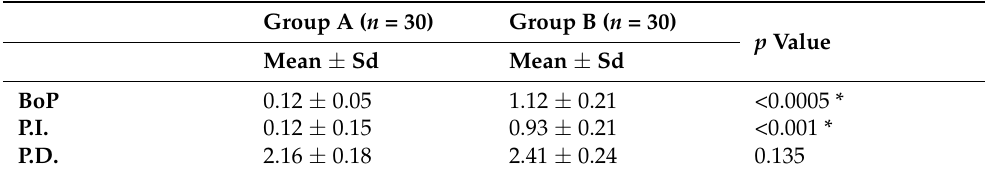
Table 4. Periodontal and microbial parameters among the A group and B group 3 months after suppression of oral irrigator in group B. (T 1 )